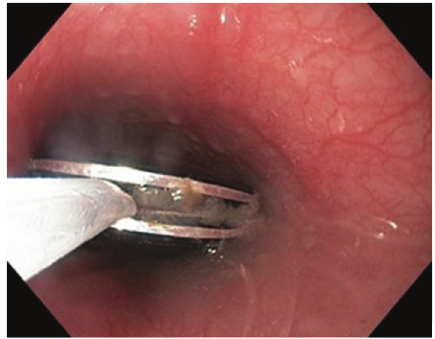
Figure 3: Successful end-on lassoing in the groove of the watch with the